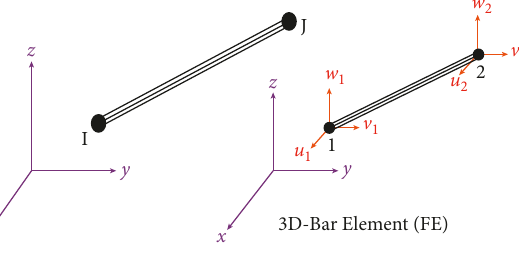
Figure 4: LINK180-3D element bars [39, 43]. Table 3: Material properties of steel reinforcement FEM.